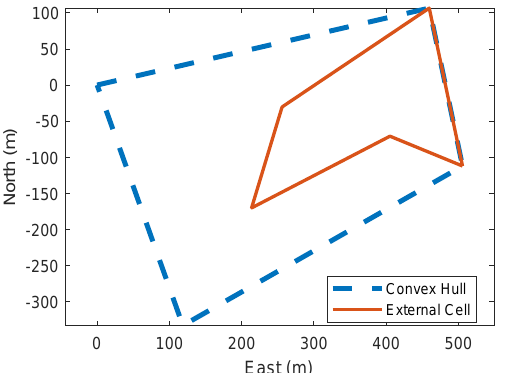
Figure 10. Convex hull, and optional external cells from the example concave polygon.